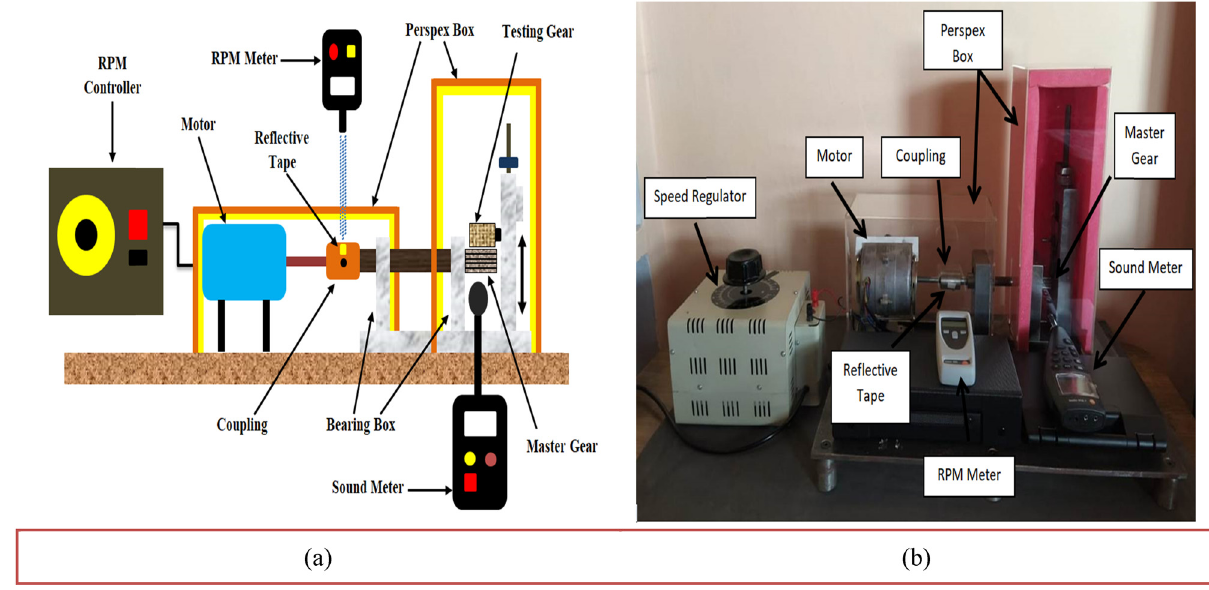
Figure 9: Noise testing setup: ( a ) schematic view and ( b ) photographic view.